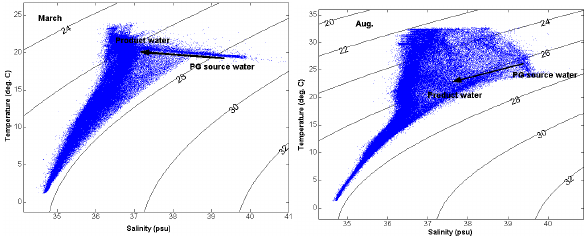
Fig. 9. T-S diagrams of water in the Oman Sea in the box shown in Fig. 5 for March (left) and August